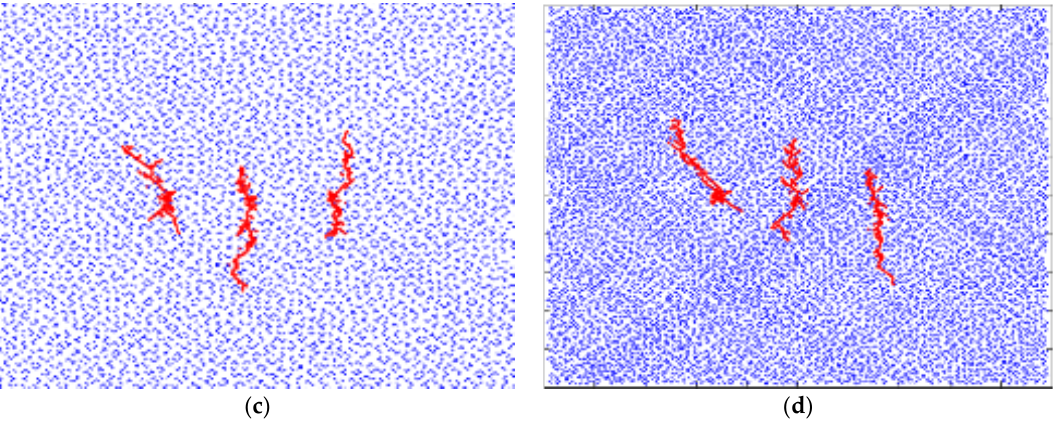
Figure 10. Fracture configuration distribution patterns during staged fracture propagation in CBM reservoirs under various fractal dimensions of natural joints. ( a ) 1.2662, ( b ) 1.2716, ( c ) 1.2806, ( d ) 1.2998.